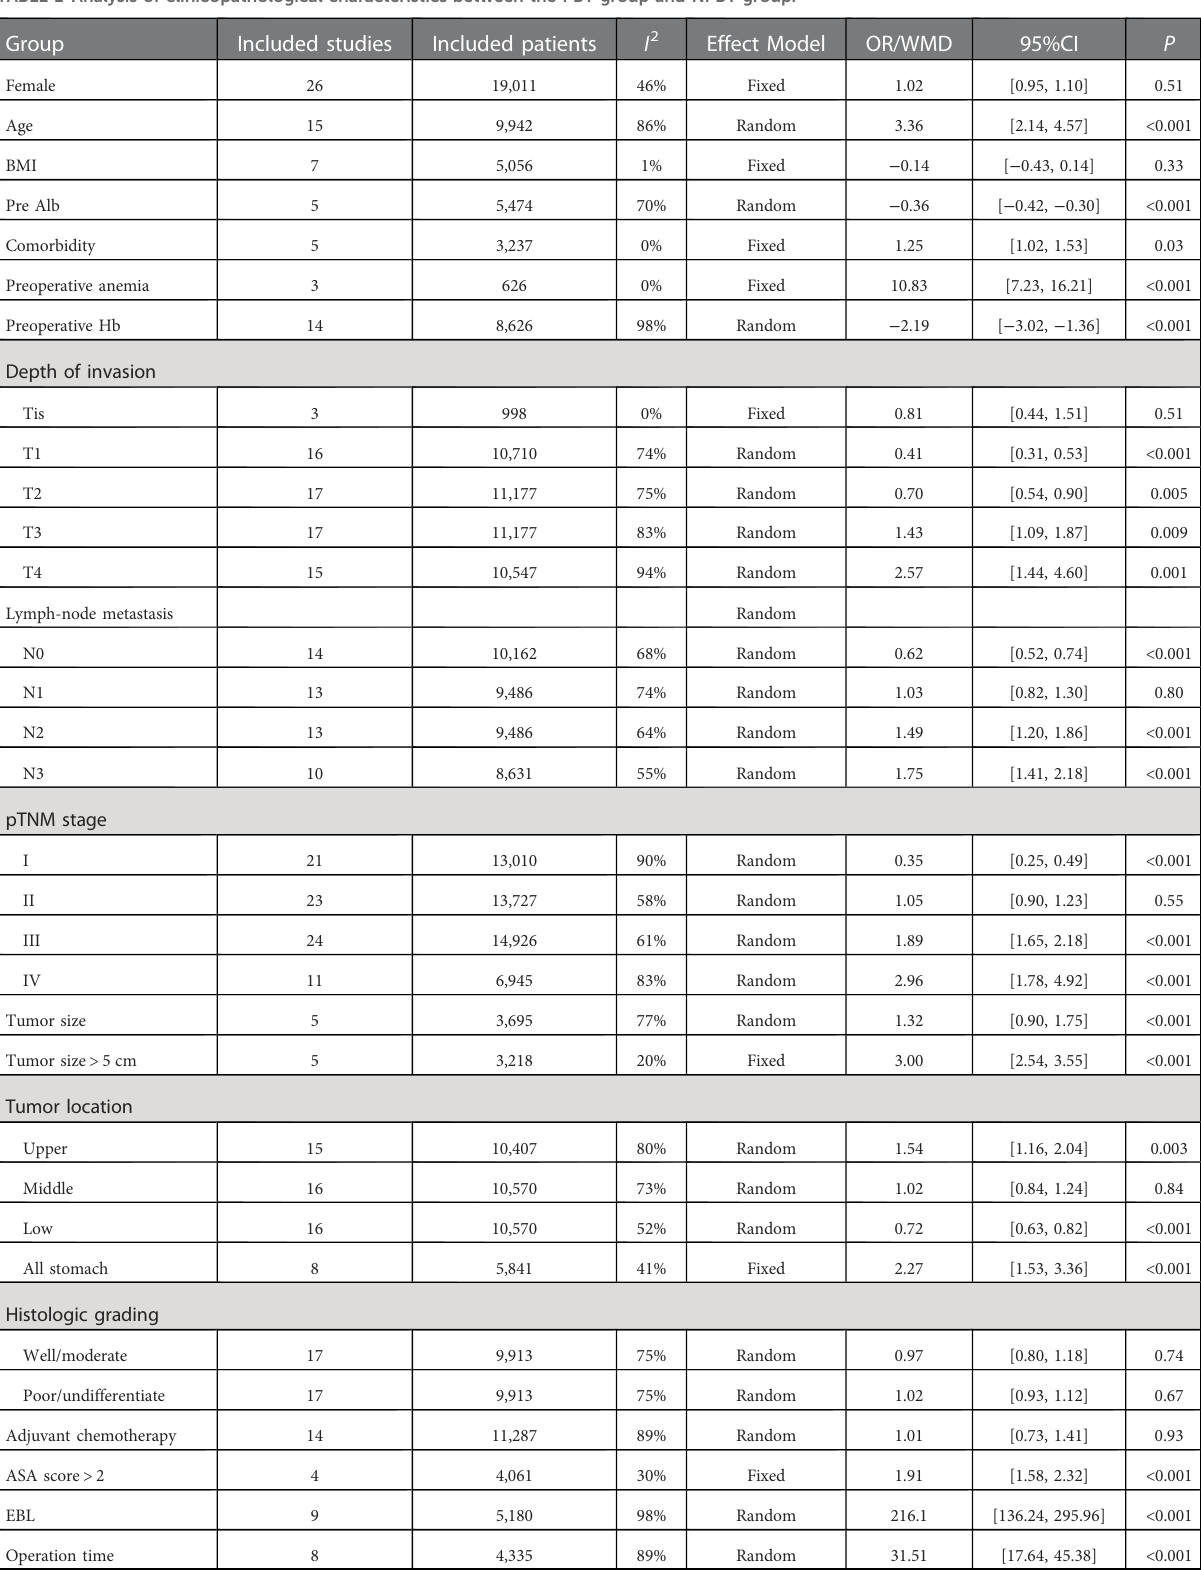
TABLE 1 Analysis of clinicopathological characteristics between the PBT group and NPBT